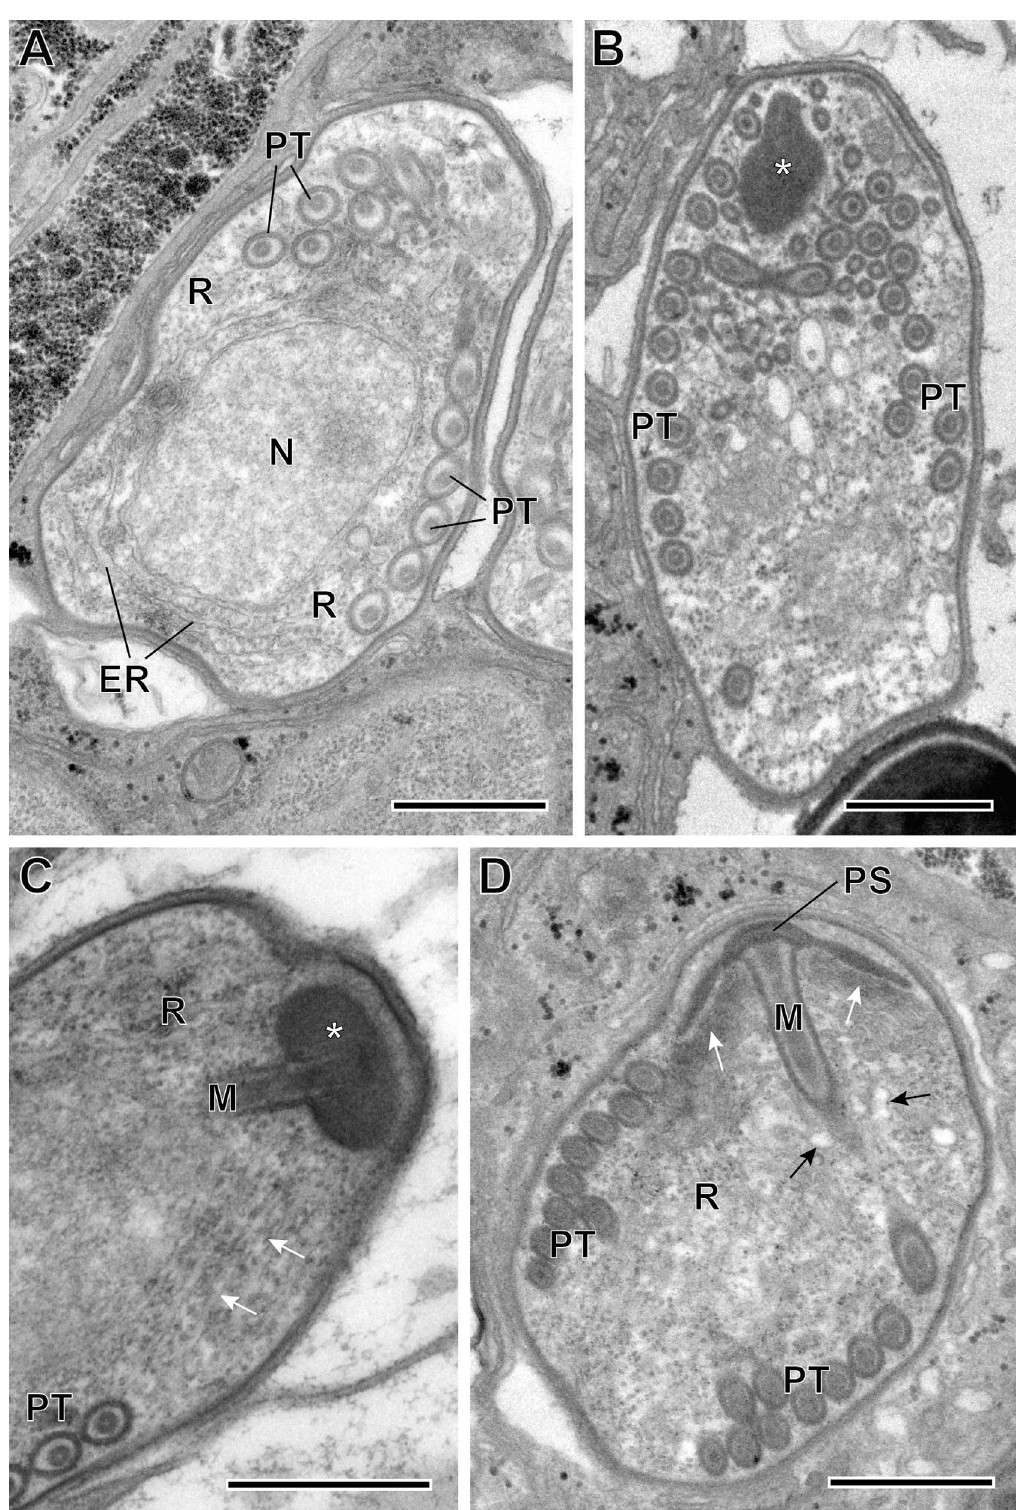
Figure 6. (A – D) Sporoblasts of Toguebayea baccigeri n. gen., n. sp . Note the fl attened saccules (white arrows) and the dilated saccules (black arrows) originating in the lamellar part and the granular or vesicular part of the polaroplast, respectively. *, amorphous electron-dense anterior material; ER, endoplasmic reticulum; M, manubrium; N, nucleus; R, ribosomes; PS, polar sac; PT, polar tube. Scale bars = 0.5 l